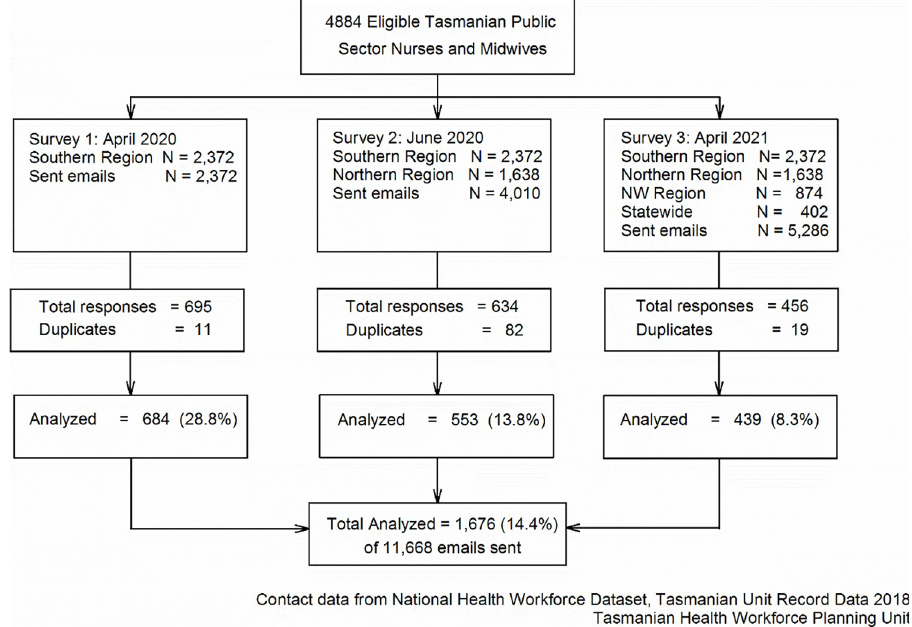
Fig 2. Respondent flow diagram (National health workforce dataset, Tasmanian unit record data